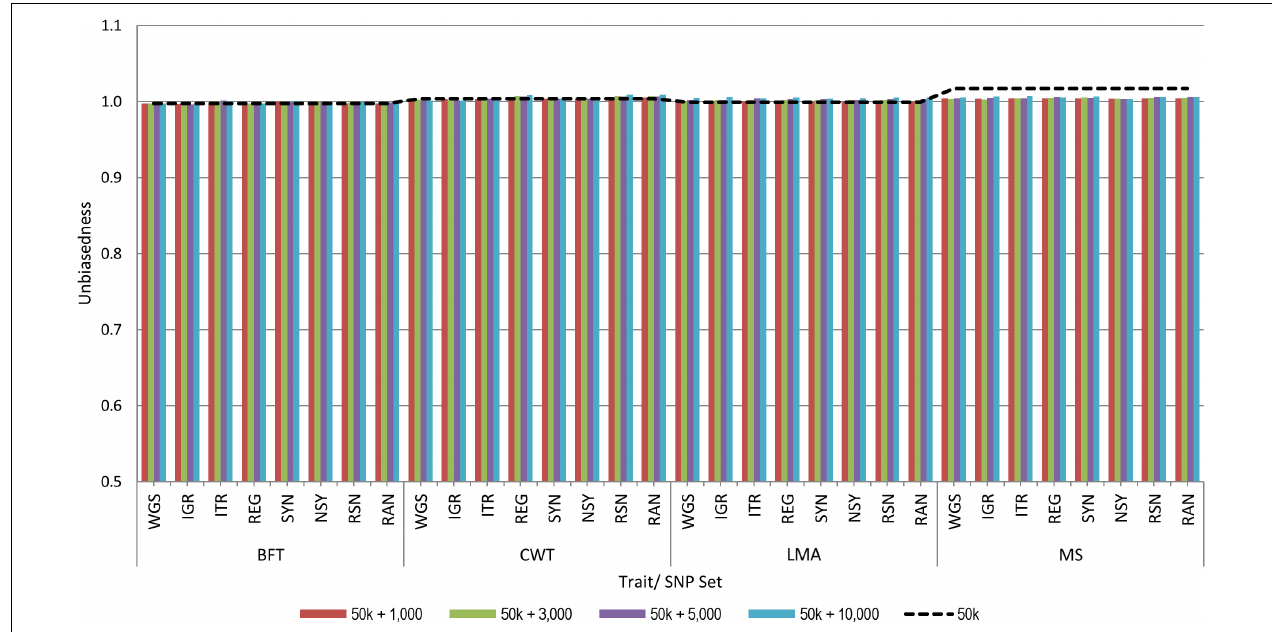
FIGURE 2 | Unbiasedness of genomic predictions using 50 k SNP panel with trait-specific pre-selected variants from different genomic regions. The added variants to the 50 k panel have different densities of 1,000, 3,000, 5,000, or 10,000. The black dashed line indicates the unbiasedness of prediction using the 50 k SNP panel only. These traits were backfat thickness (BFT), carcass weight (CWT), longissimus muscle area (LMA), and marbling score (MS). Whole-genome sequence (WGS); intergenic (IGR); intron (ITR); regulatory (REG); synonymous (SYN); non-synonymous (NSY); combination of regulatory, synonymous, non-synonymous (RSN); and randomly selected from WGS